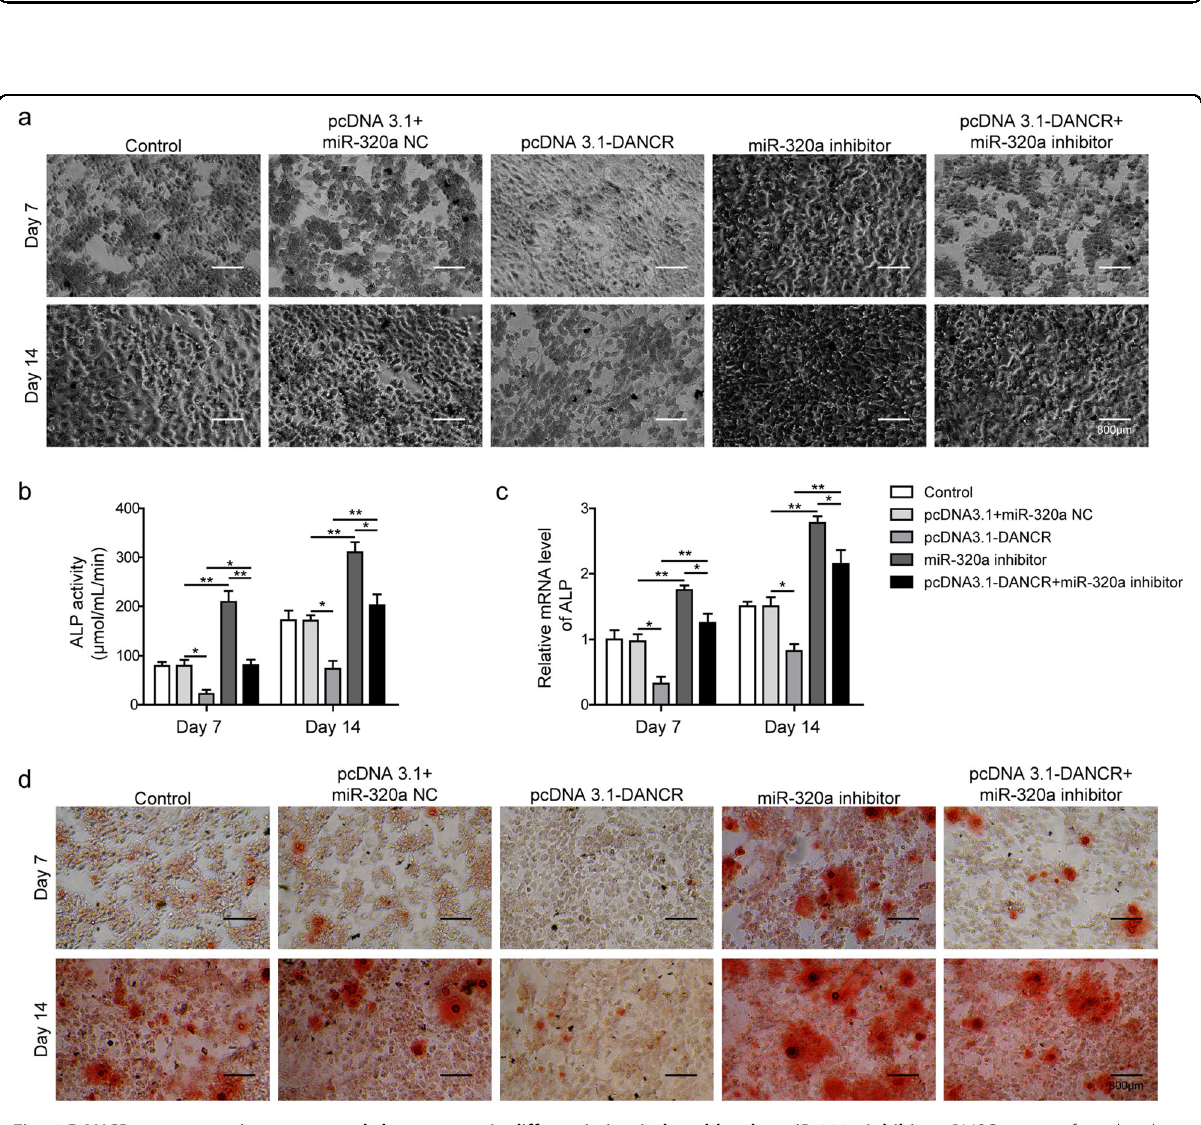
Fig. 6 DANCR overexpression attenuated the osteogenic differentiation induced by the miR-320a inhibitor. BMSCs were infected with lentivirus encoding miR-320a inhibitor and/or DANCR overexpression vector, followed by incubation in osteogenic differentiation induction medium for 7 or 14 days. Cells were subsequently stained with a ALP and d Alizarin Red and observed under an inverted microscope. b Cells were lysed, and the relative ALP activity was detected. c Relative mRNA expression of ALP was determined by qRT-PCR. All experiments were conducted independently at least three times. * P < 0.05 and ** P <